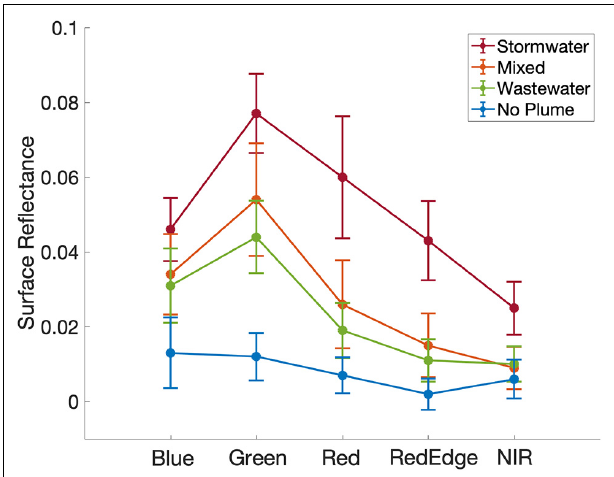
FIGURE 3 | Line graph of surface reflectances for 10 stormwater plumes, 10 wastewater plumes, 10 mixed plumes, and 10 open ocean events. The y -axis indicates the surface reflectance values and the x -axis is the wavelength. The bounding bars are the ± 1 standard deviation from the average spectral value.